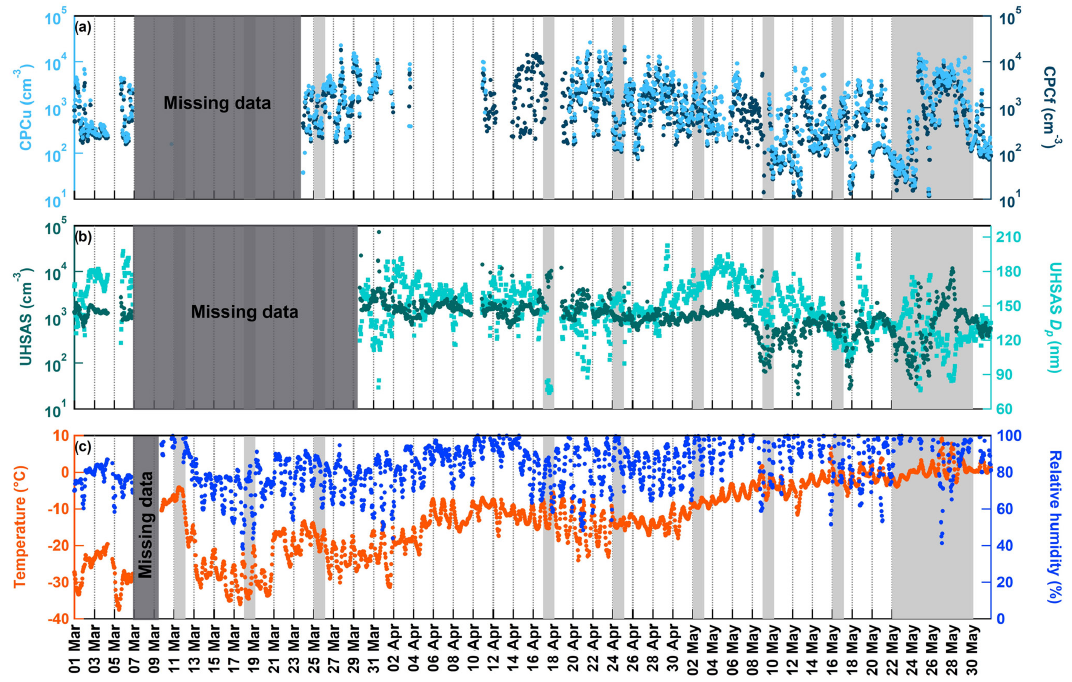
Figure 2. Time series of hourly-averaged aerosol numbers and meteorological variables from AOSMET during 1 March–31 May 2017, including aerosol number concentrations measured by (a) the condensation particle counter (CPCf) and an ultrafine CPC (CPCu) and (b) the ultrahigh-sensitivity aerosol sizer (UHSAS). Average hourly mean particle diameter ( D p ) is also shown from the UHSAS in (b) . Meteo- rological data include (c) relative humidity and air temperature. Light grey shading represents days where samples were analyzed for INP concentrations. Dark grey shading represents times with missing